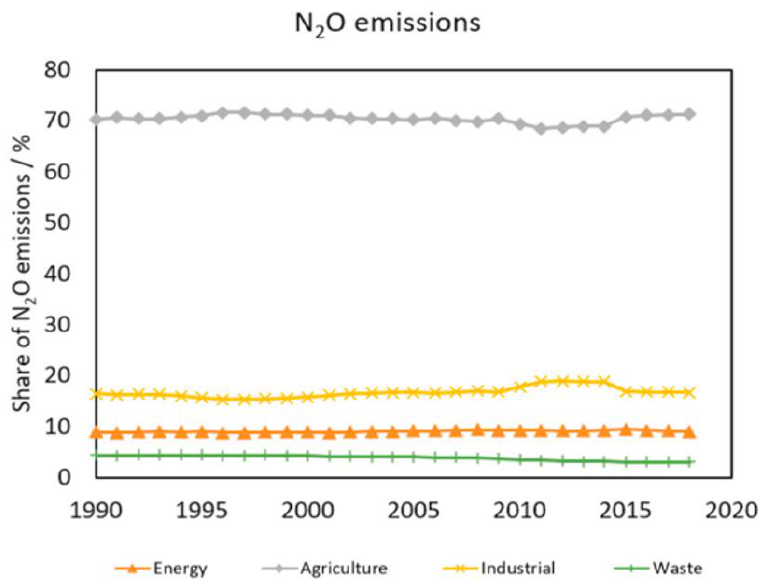
Figure 2. Share of N 2 O emissions by sector, from 1990 to 2018 [7].